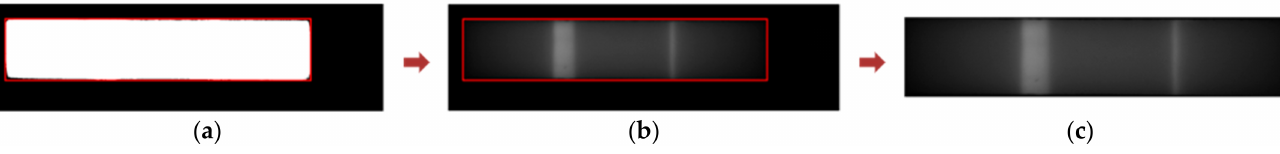
Figure 7. Segmentation of the NC membrane. ( a ) Obtaining the bounding box from the final flow map. ( b ) Mapping the obtained bounding box onto the input image frame. ( c ) Segmented out NC